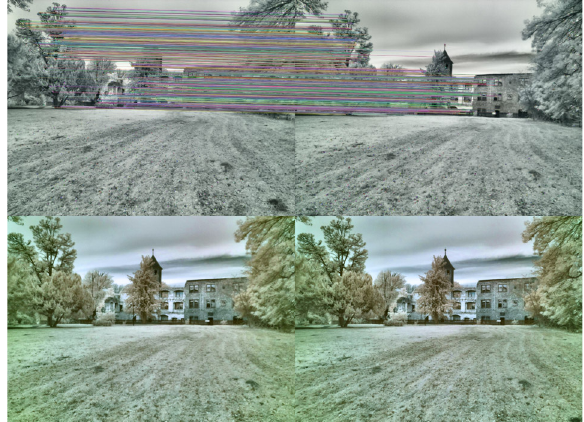
Figure 6: Stereo image rectification, the uncalibrated case